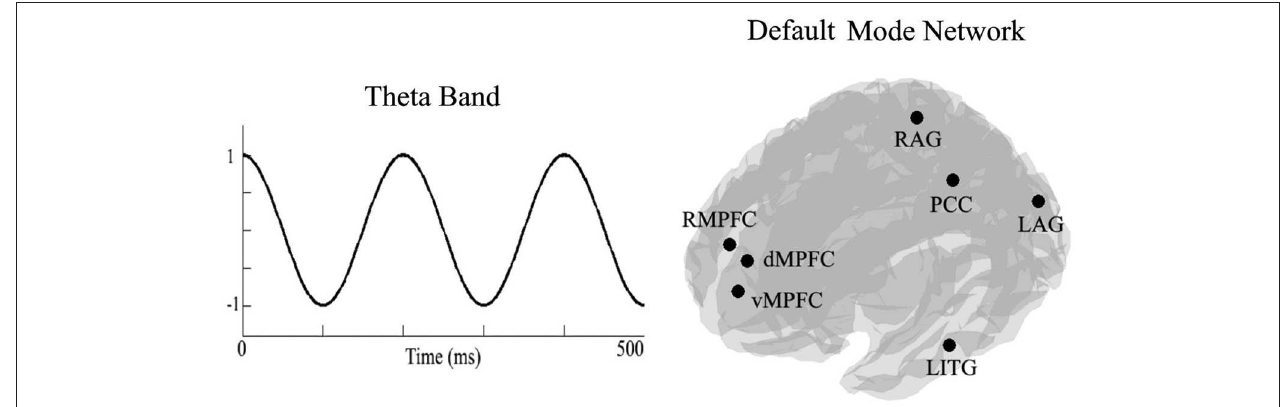
FIGURE 2 | On the left side an, illustration of the theta frequency band (4–7Hz). On the right side, an illustration of locations of the seven seeds of the default mode network. RMPFC, right medial pre-frontal cortex; dMPFC, dorsomedial pre-frontal cortex; vMPFC, ventromedial pre-frontal cortex; RAG, right angular gyrus; LAG, left angular gyrus; PCC, posterior cingulate cortex/precuneus; LITG, left inferior temporal gyrus.